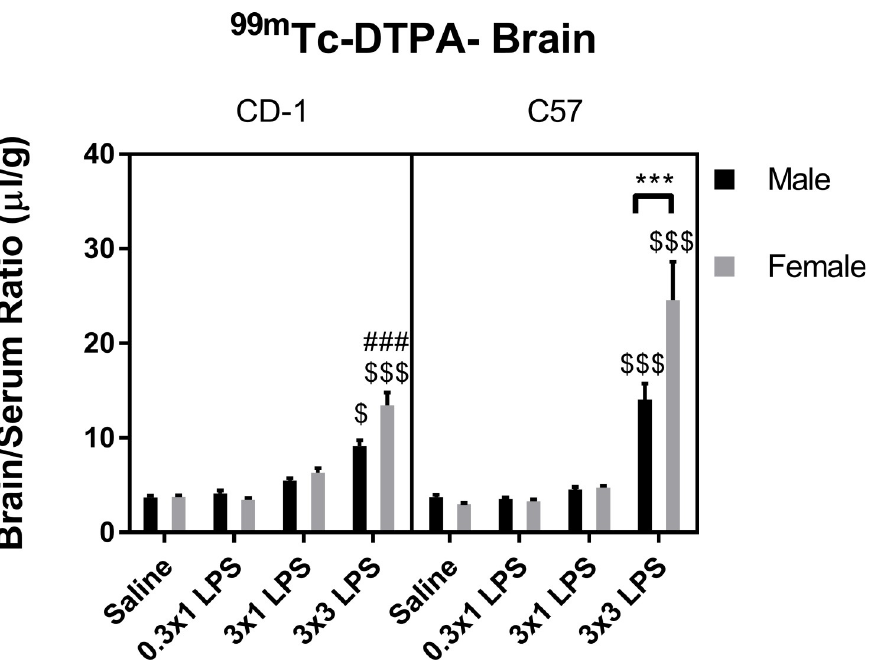
Fig 2. Effects of LPS on brain/serum ratios of 99m Tc-DTPA. Data are presented as means ± SEM, n = 8 per group. $p < 0.05, $$ $p < 0.001 vs. saline treatment within the same sex and strain. ###p < 0.001 vs. C57 within the same treatment group and sex. ��� p < 0.001 vs. groups indicated, within the same strain and treatment.